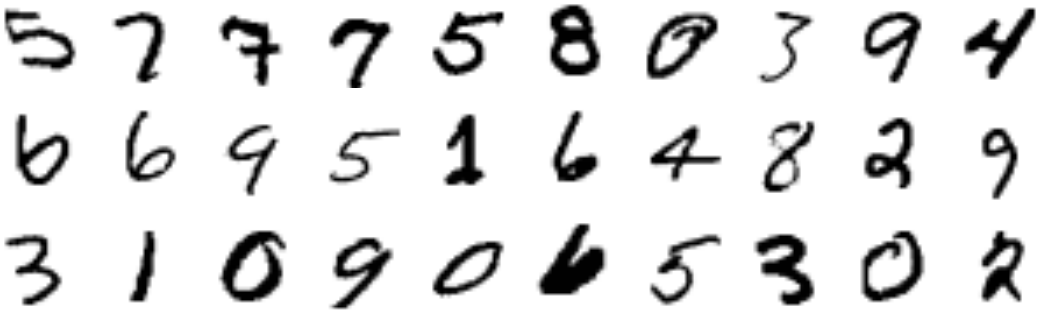
Figure 2. Example images of the MNIST